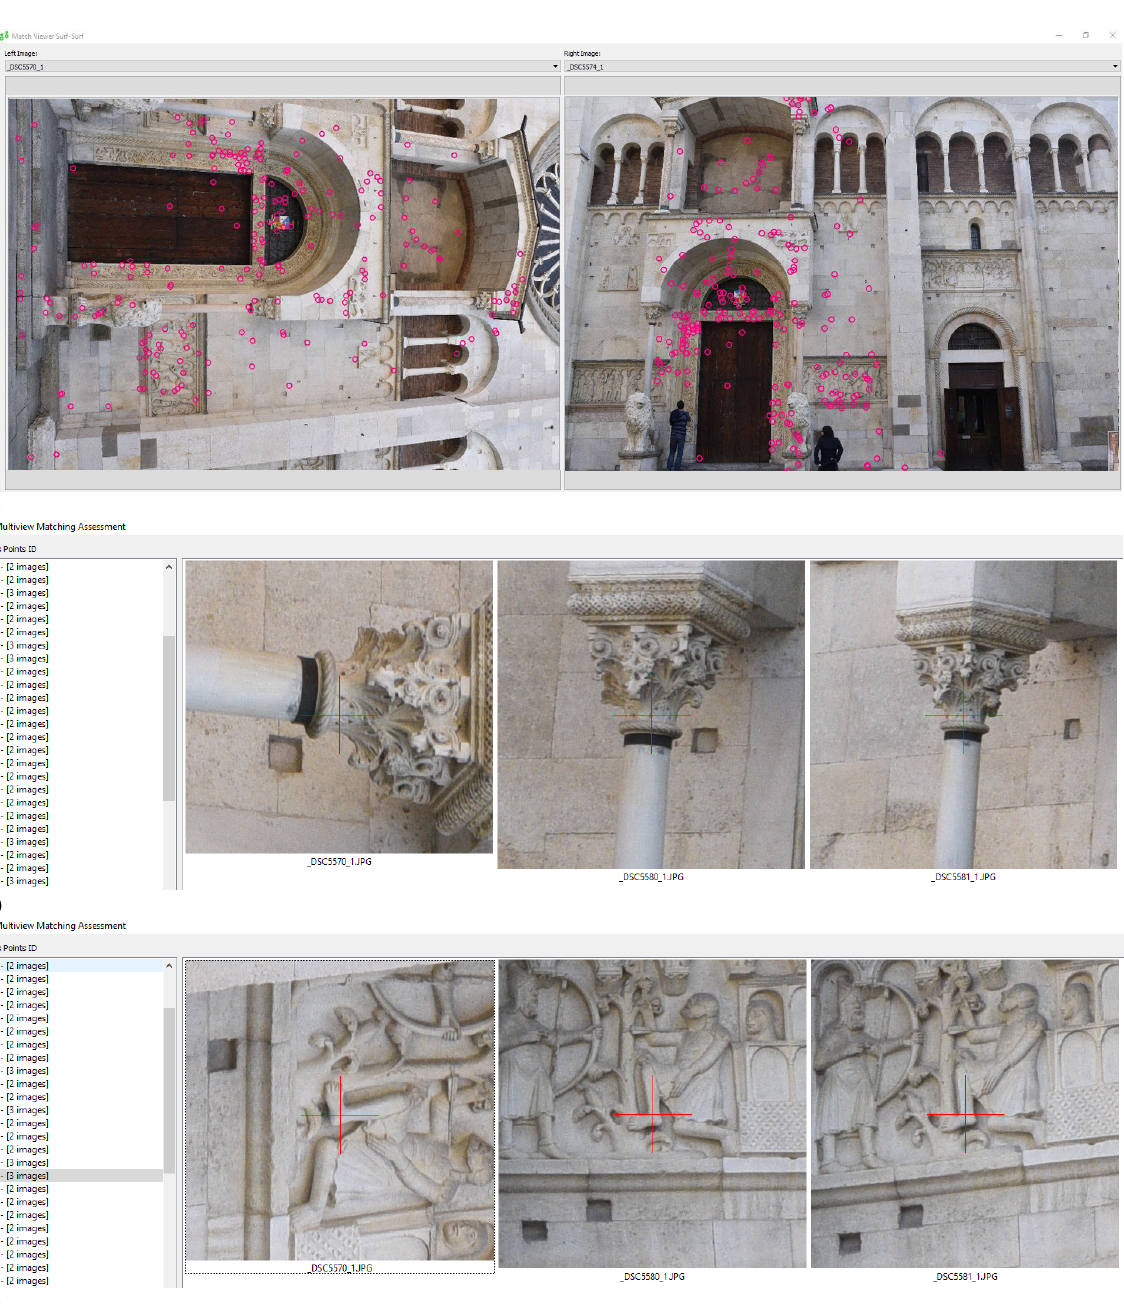
Figure 5: Examples of the features extraction based on SURF-SURF (a) and matching results (b and c) on the multi-view Modena Cathedral